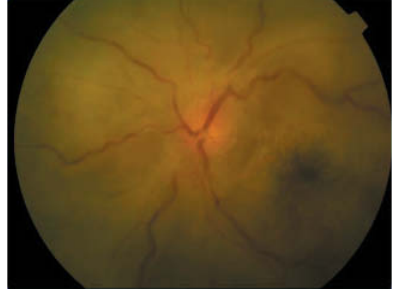
Spread to subarachnoid space is rare and can be detected with cytology.